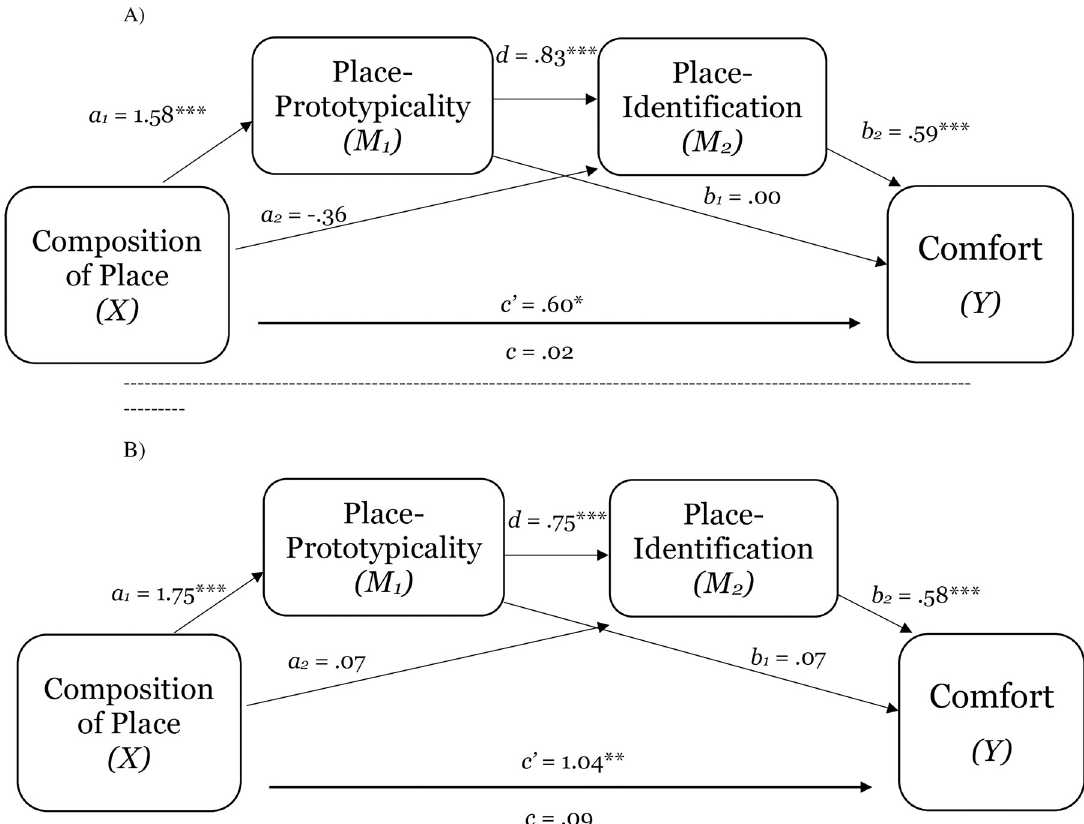
Fig 3. The serial mediating effect of place-prototypicality and place-identification in the relation between composition of place and comfort in Study 1b (Panel A) and Study 1c (Panel B). Notes: � p < .05, �� p < .01, ��� p < .001; All presented effects are unstandardized; c’ is direct effect of composition of place on comfort; c is total effect of composition of place; d is effect of place-prototypicality on place- identification (sense of